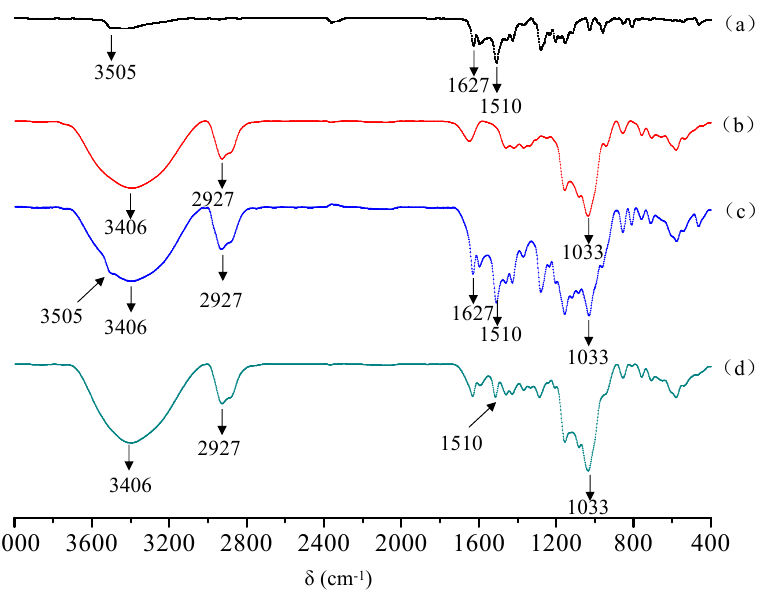
Figure 2. FTIR spectra of curcumin ( a ); cyclodextrin polymer ( b ); curcumin and cyclodextrin polymer physical mixture ( c ); curcumin/cyclodextrin polymer inclusion complex ( d ).